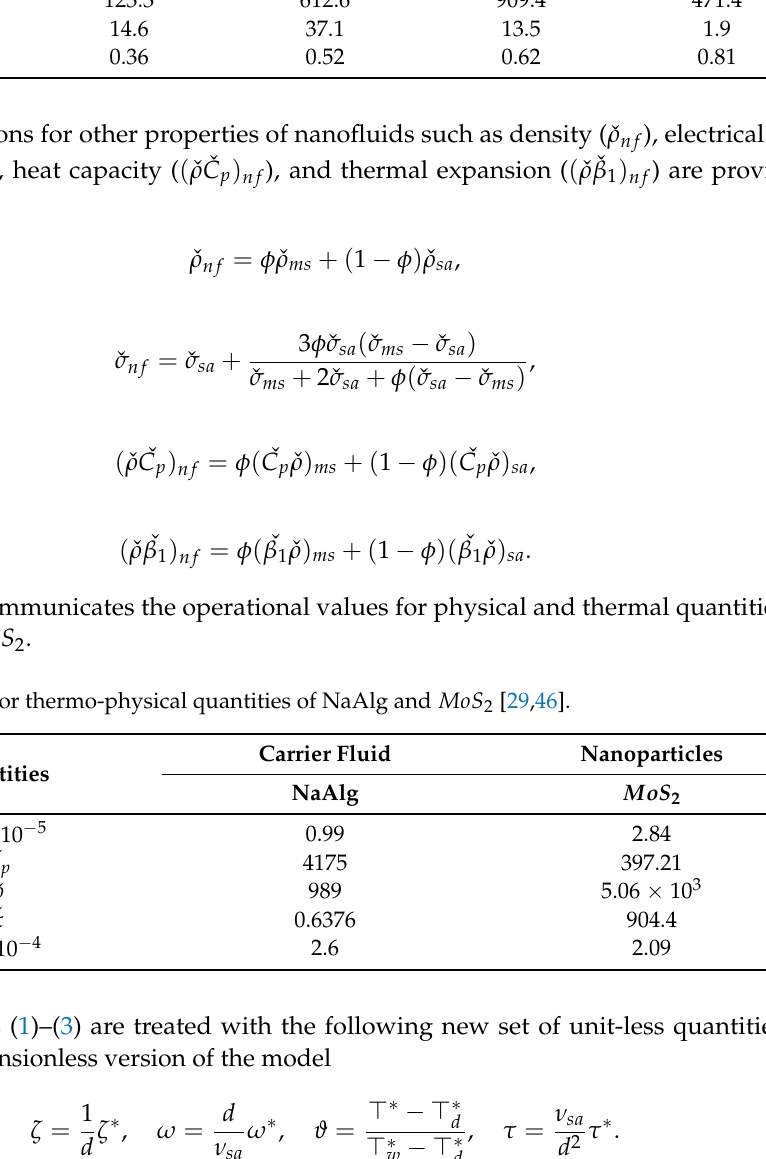
Table 1. Numerical values of ˇ a , ˇ b , and ψ for considered shapes [29]. Model Blade Platelet